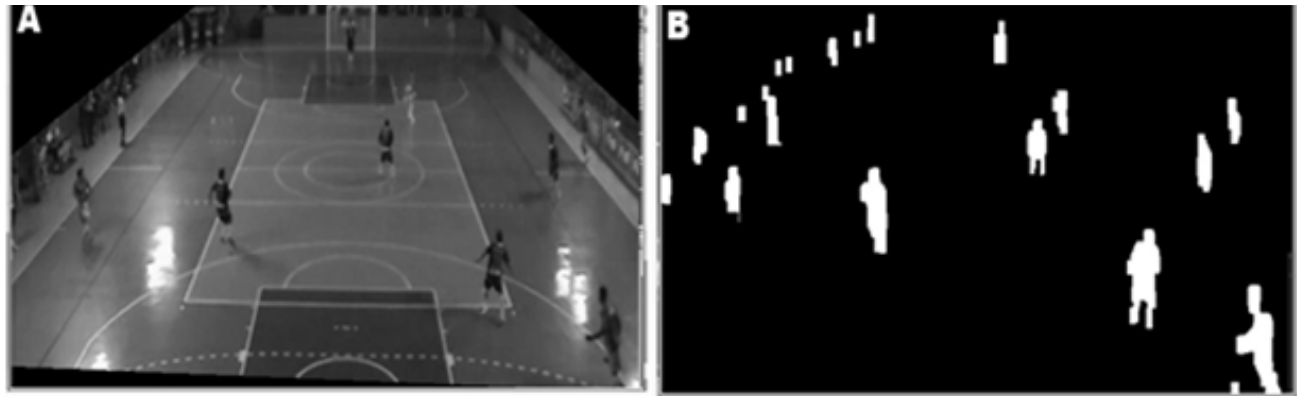
Figure 2. Example of one frame during the image segmentation process based on morphological filtering in DVideo TM environment. A = actual frame. B = binary image.